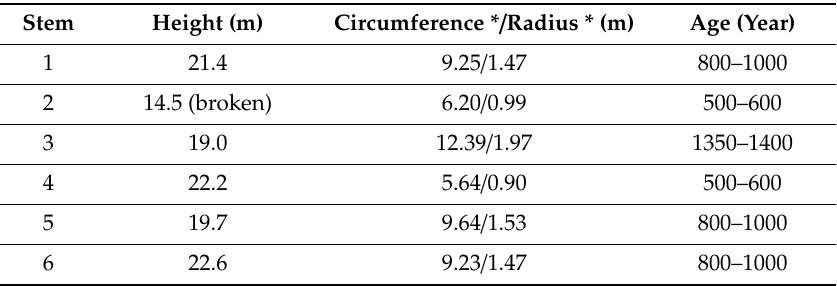
Table 2. Dimensions and ages of Chapman baobab’s